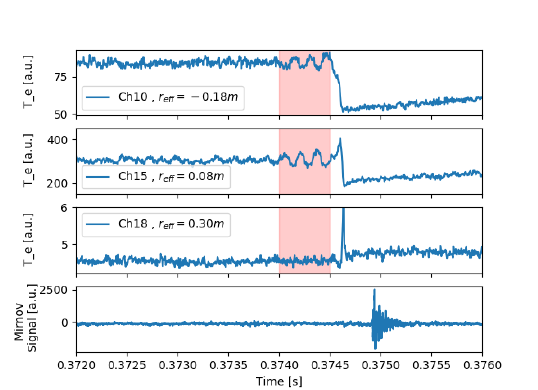
Figure 4 : ECE (first three time traces) and Mirnov coil signal (fourth time trace) before a temperature collapse. Strong oscillation are visible in channel 10 and 15 (red box), while weak oscillation are slightly visible on channel 18.